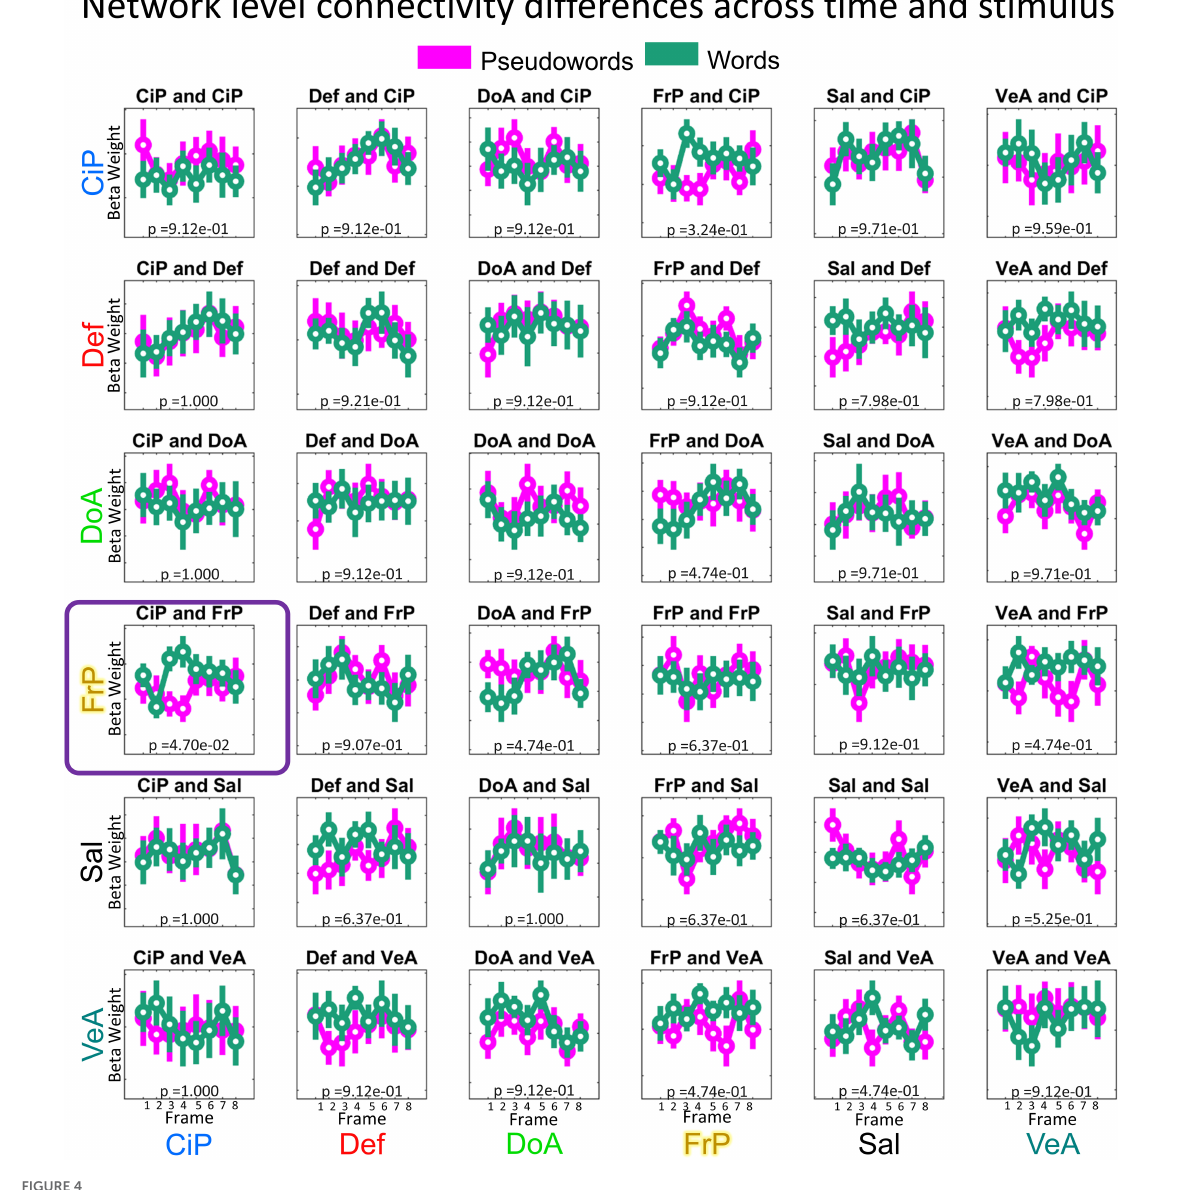
FIGURE4 Distribution of connectivity values per functional network pair and condition. Beta-weights were calculated for each condition as indicated in our experimental design ( Figure 3 ) and grouped by functional network pair. Each boxplot highlights the mean values using a circle and the dispersion is indicated with a bar covering 1.15 times the standard deviation of the connectivity values. Data is color-coded by stimuli: pseudoword (purple) and word (green). X -axis indicates the time, in frames (TR of 2.5 s each). In this study we included the following six networks: Cingulo-Parietal (CiP, n = 5 Regions of Interest), Default (Def, n = 41), Dorsal Attention (DoA, n = 32), Fronto-Parietal (FrP, n = 24), Salience (Sal, n = 4), and Ventral Attention (VeA, n =